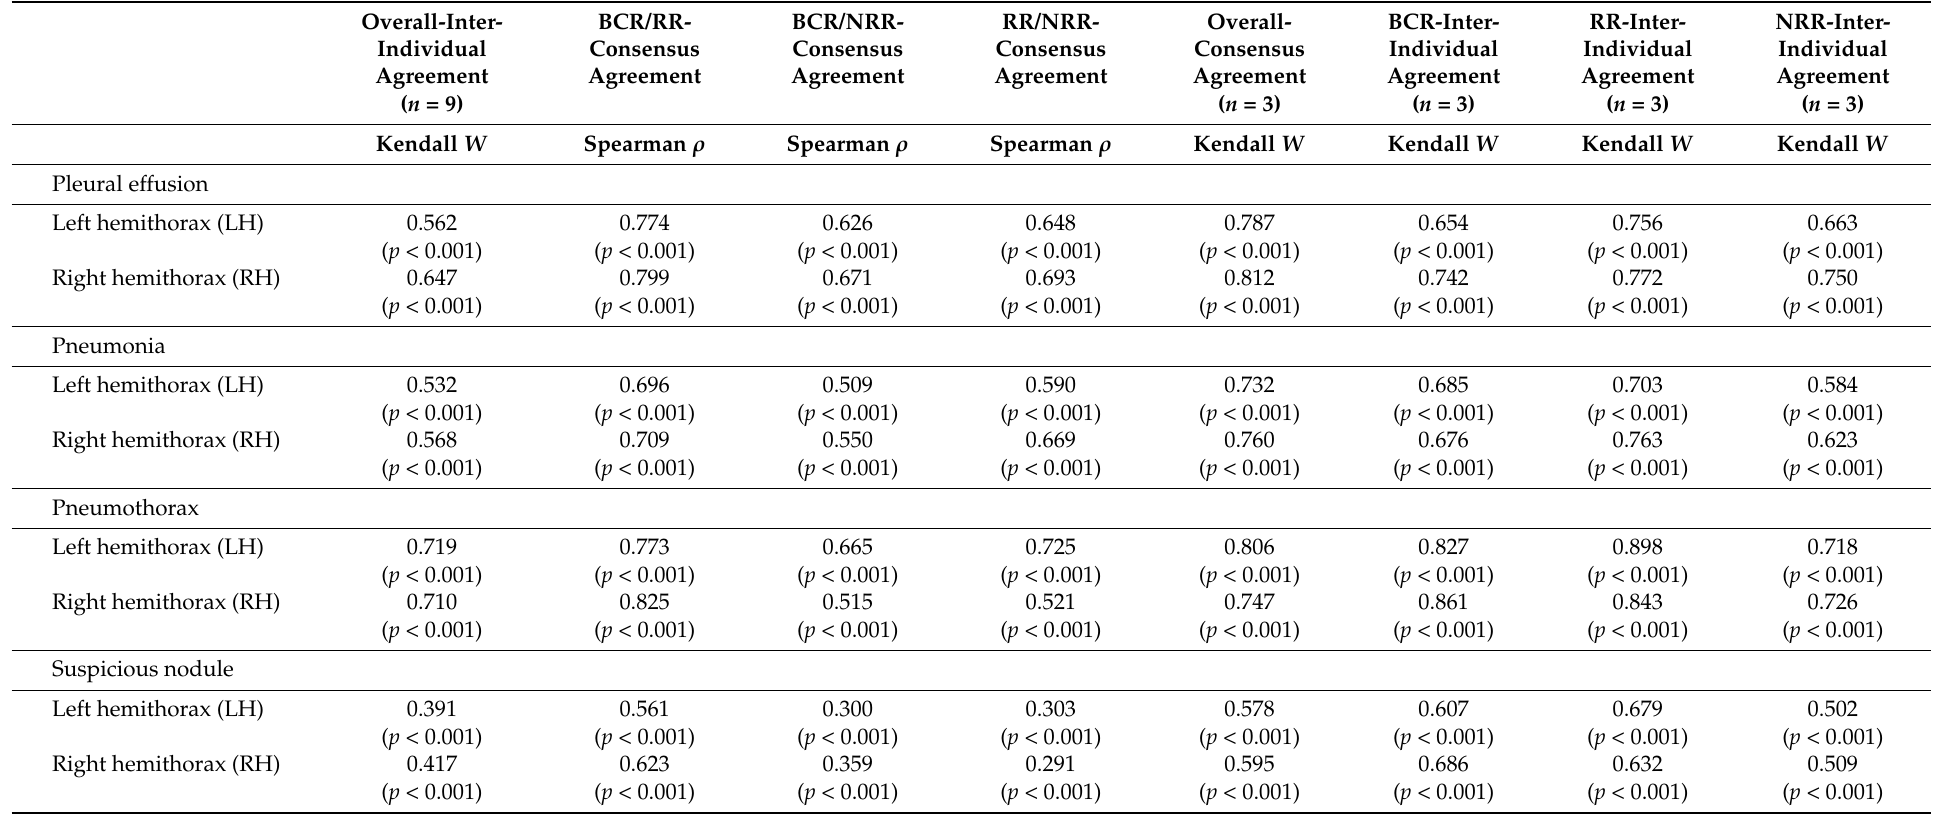
Table 2. Quantification of interrater and consensus agreements by interrater reliability and correlation analysis—Kendall’s coefficient of concordance (Kendall W) was calculated for overall-inter-individual agreement, inter-individual agreement among group’s readers (BCR, RR and NRR) and overall-consensus agreement. Consensus agreement comparing the three reading groups (BCR, RR and NRR) pairwise was established with interrater correlation (Spearman’s Rho). Different tests were performed because the number ( n ) of compared reading results differed (in consensus agreement n = 2, while n = 3 in BCR/RR/NRR-inter-individual agreement and overall-consensus agreement ´ and n = 9 in overall-inter-individual agreement). Spearman’s Rho was used if n = 2 and Kendall W if n > 2. All calculated values showed p <